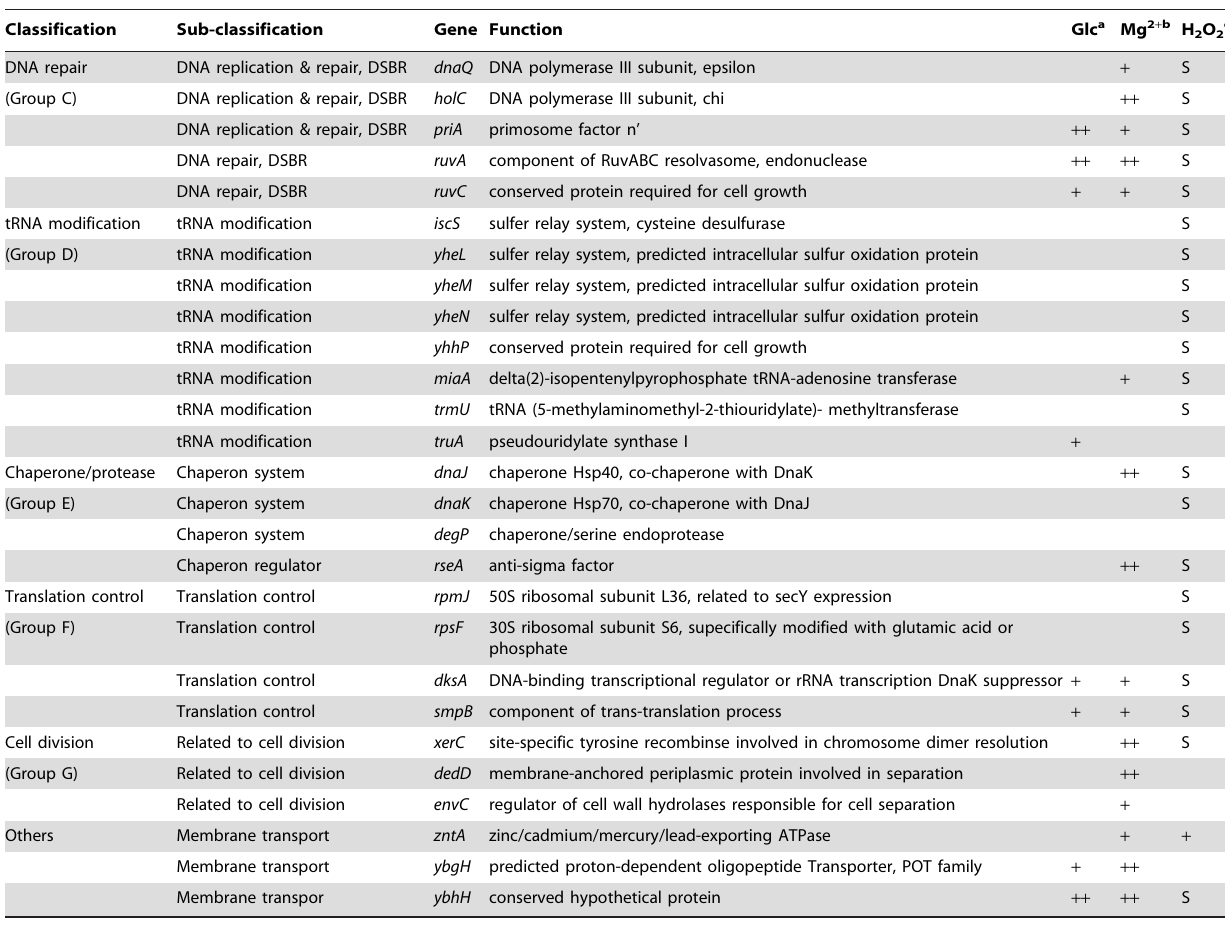
Table 2. Thermotolerant genes identified in this study.